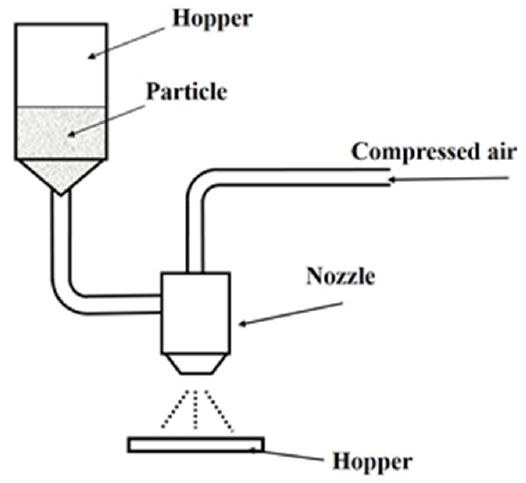
Figure 1. Blasting equipment.